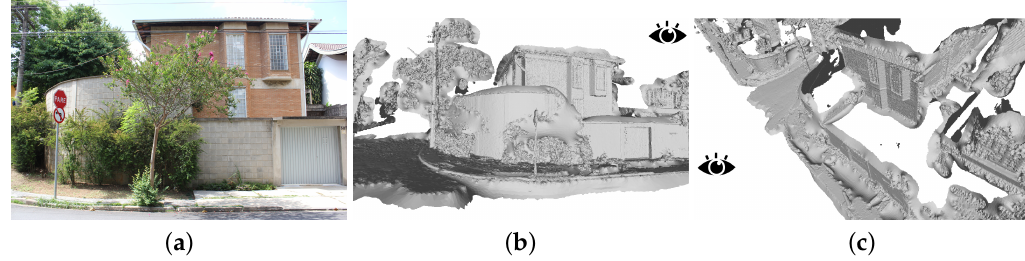
Figure 13. 3D model of SJC. ( a – c ) Example of the gap between the gate and the façade, often present in this specific architectural style; (c) represents the point of view in (b), and vice versa.